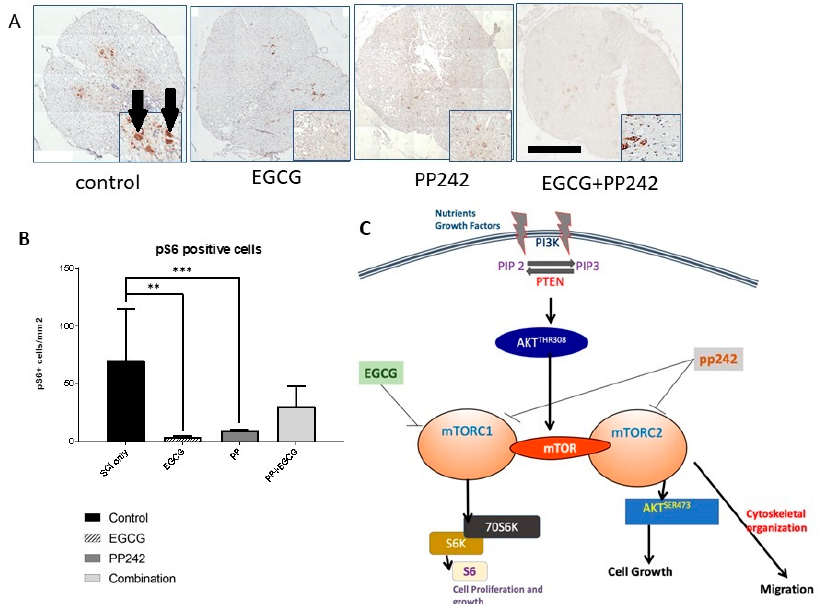
Figure 5. Phospho-S6-positive cells in spinal cord section at the lesion site . ( A ) The photomicrograph shows staining of phospho-S6-positive (pS6) cells per mm 2 in the spinal cord section from the lesion center site. Scale bar 500 µ m ( B ) Quantitative analysis of pS6-positive cells showed a reduced number